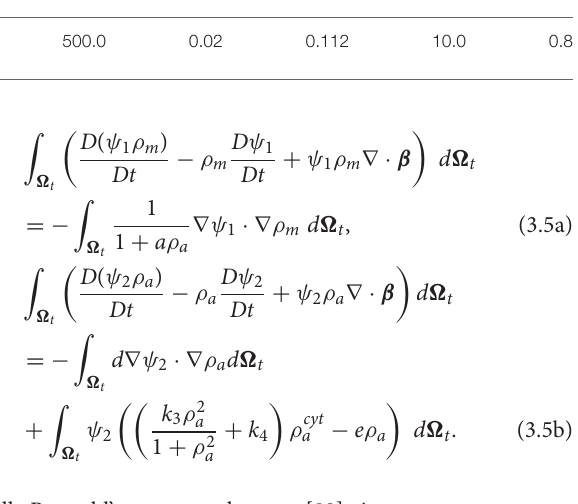
TABLE 2 | Non-dimensional parameter values for the non-dimensionalized viscous model.